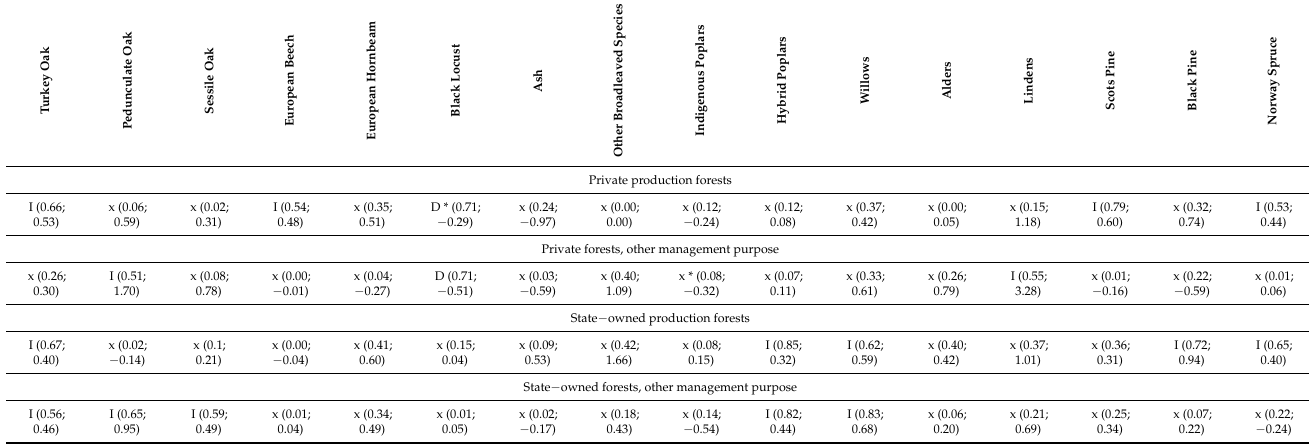
Table A2. The trend of the harmonic means of harvesting ages (weighted by the area under harvest) of the examined tree species and tree species groups in the period between 2006 and 2021. (“I” means increasing trend, “D” means decreasing trend, while “x” means that no trend could be observed. The first number in brackets is the value of the determination coefficient R 2 . The second number in brackets is the parameter ‘a’ of the trendline. The * indicates that there was a significant decrease in the harmonic mean of the cutting ages between 2016 and